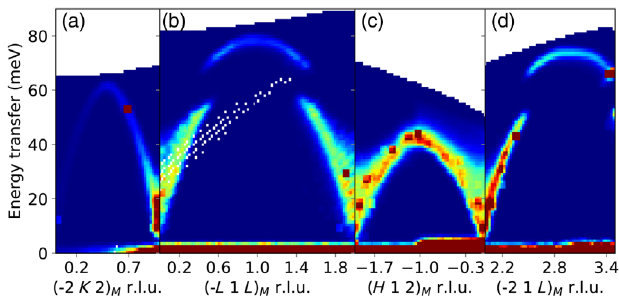
exchange constants from scattering data. Comparison of column 5 in Table I and column 4 of Table III indicates